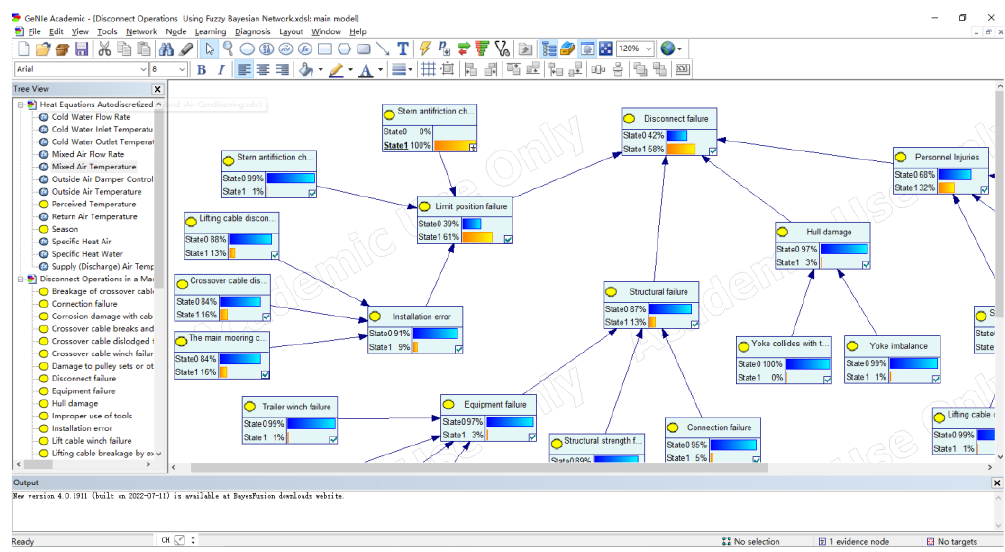
Figure 8. Bayesian Network diagram using GeNIe.